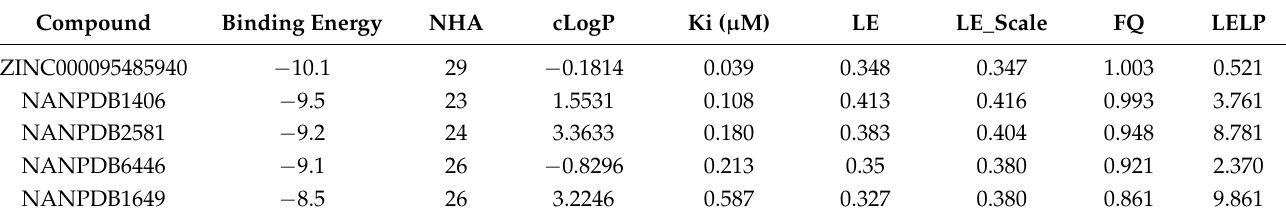
Table 9. Ligand quality assessment metrics for selected compounds. The metrics include inhibitory constant (Ki), ligand efficiency (LE), LE scale (LE_scale), fit quality (FQ), LE-dependent lipophilicity (LELP), and calculated logP (cLogP).